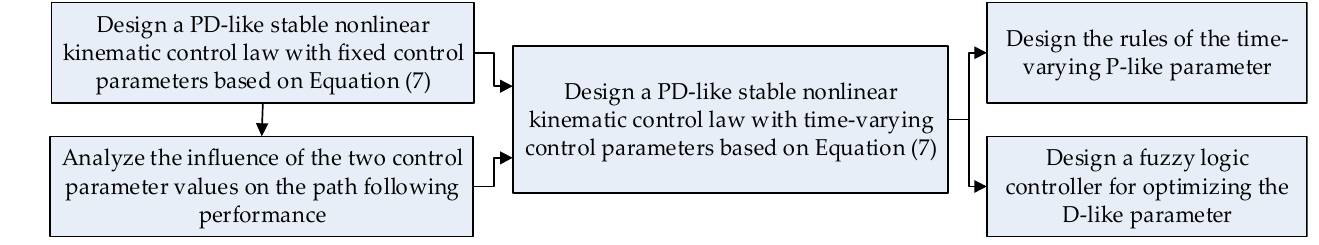
Figure 2. The sketch of the solution to the curved-path following controller with parameters adap-